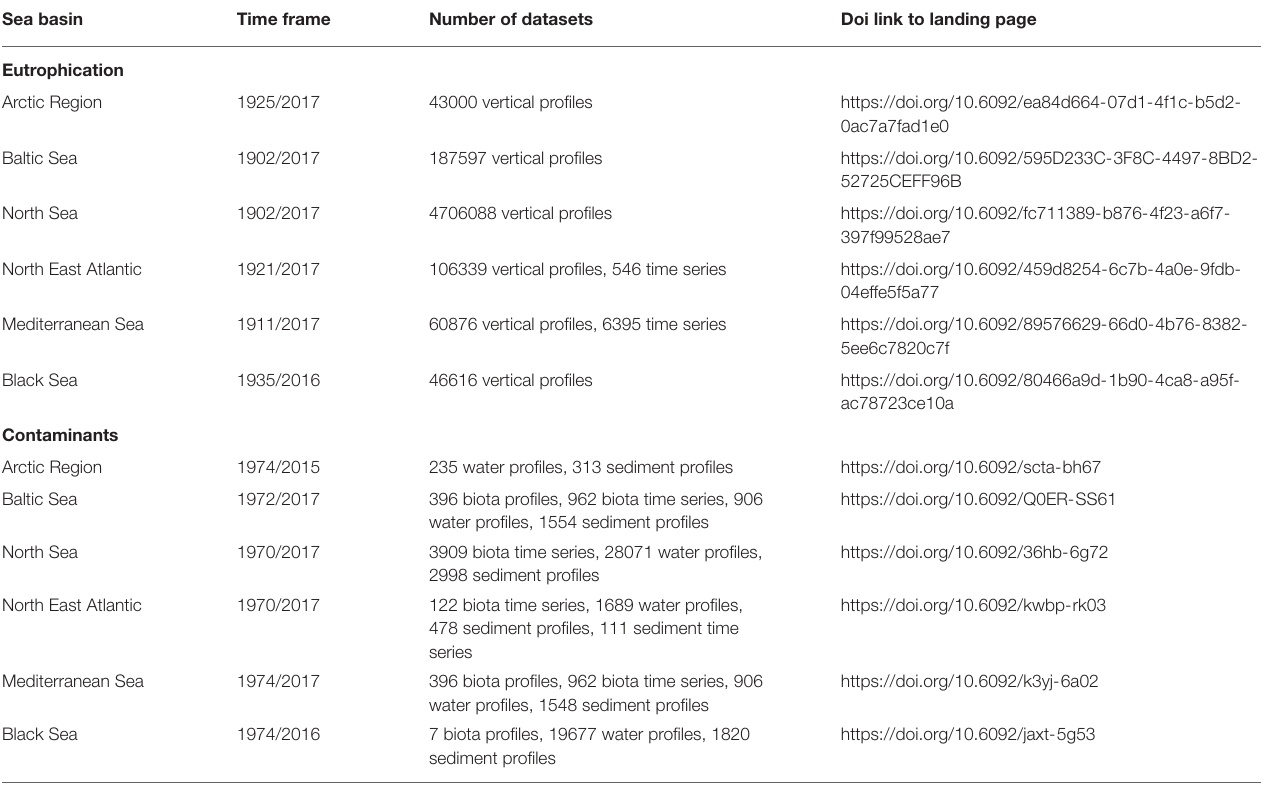
TABLE 1 | Spatial/temporal coverage of regional data collections, with number of profiles and doi